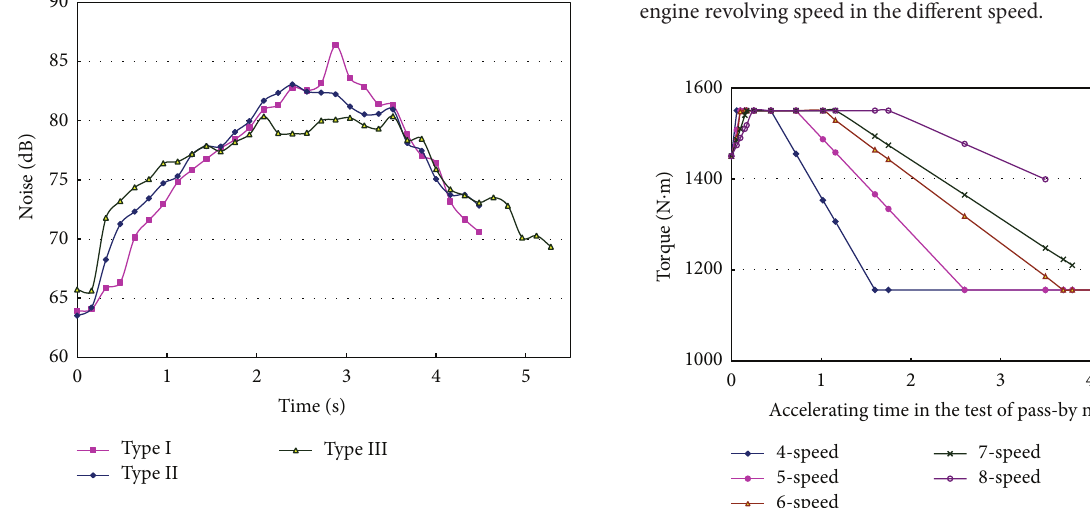
Figure 4: In the testing condition of pass-by noise, the change of engine revolving speed in the different speed.